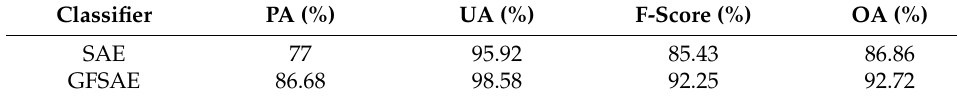
Table 6. Accuracy metrics of boundary areas for SAE and GFSAE for the CEF dataset.